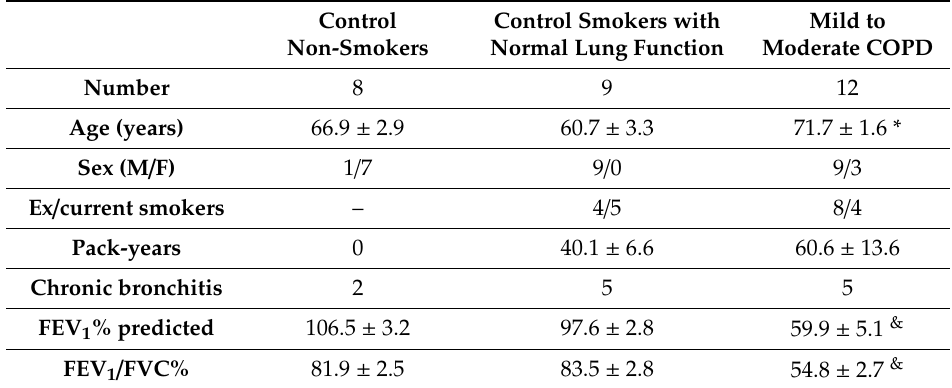
Table 5. Clinical characteristics of the subjects recruited for the Bronchoalveolar lavage (BAL)